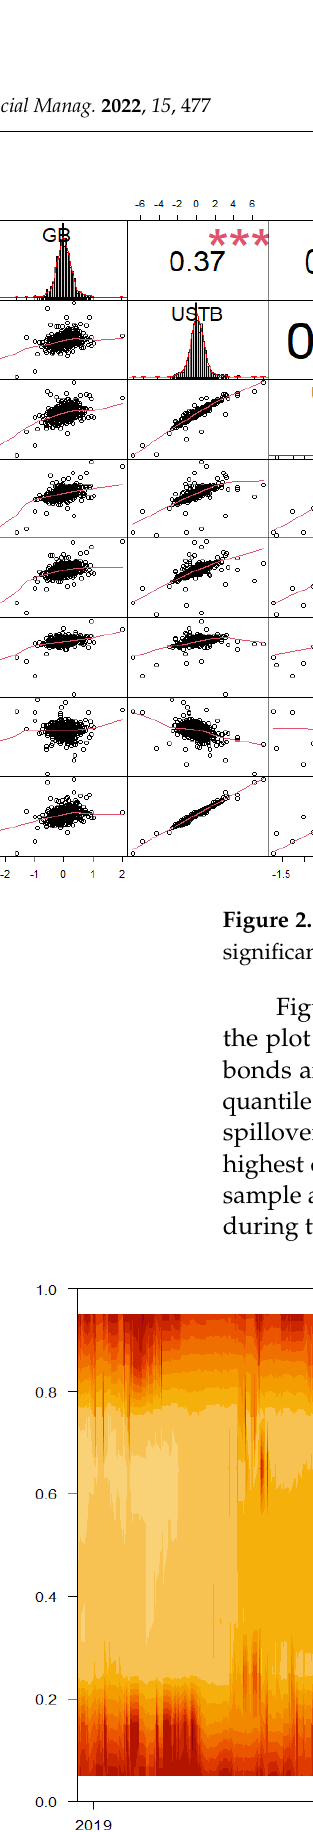
Figure 4. Results for net total directional connectedness for the S&P Green Bond Index based on a 200-day rolling-window QVAR(1) and a 20-step-ahead forecast. In Figure 5, we note that during the pre-COVID 19 period, treasury and conventional bonds steadily transmitted risk to other financial markets. The financial year 2020 was a remarkable period where the magnitude of spillover increased tremendously. Late 2020 and early 2021 witnessed a lesser degree of connectedness of treasury and conventional bonds with other financial assets. This finding is similar to the findings of Naeem et al. (2021a), who urged that there exists a moderate spillover effect between green bonds and other bond indices. This may be due the upspringing of returns on stocks and commodi- ties. In Figure 6, we can observe the aggregate bond index emanated as a net transmitter of risk across other financial markets. The connectedness suddenly increased with the on- set of the COVID-19 pandemic and it was highest during mid-2020. However, in the lower